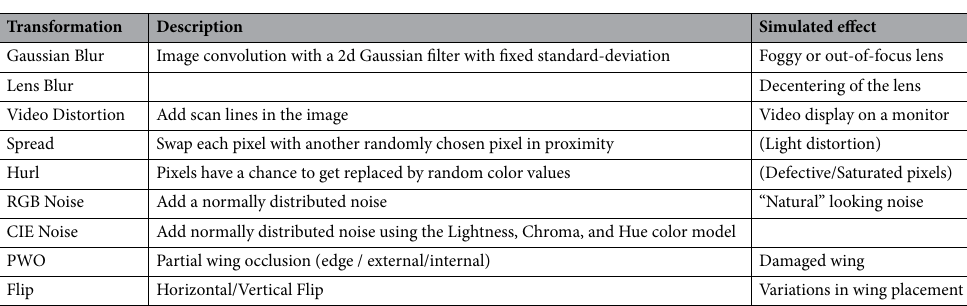
Table 2. Description of the transformation used for the evaluation of the algorithm